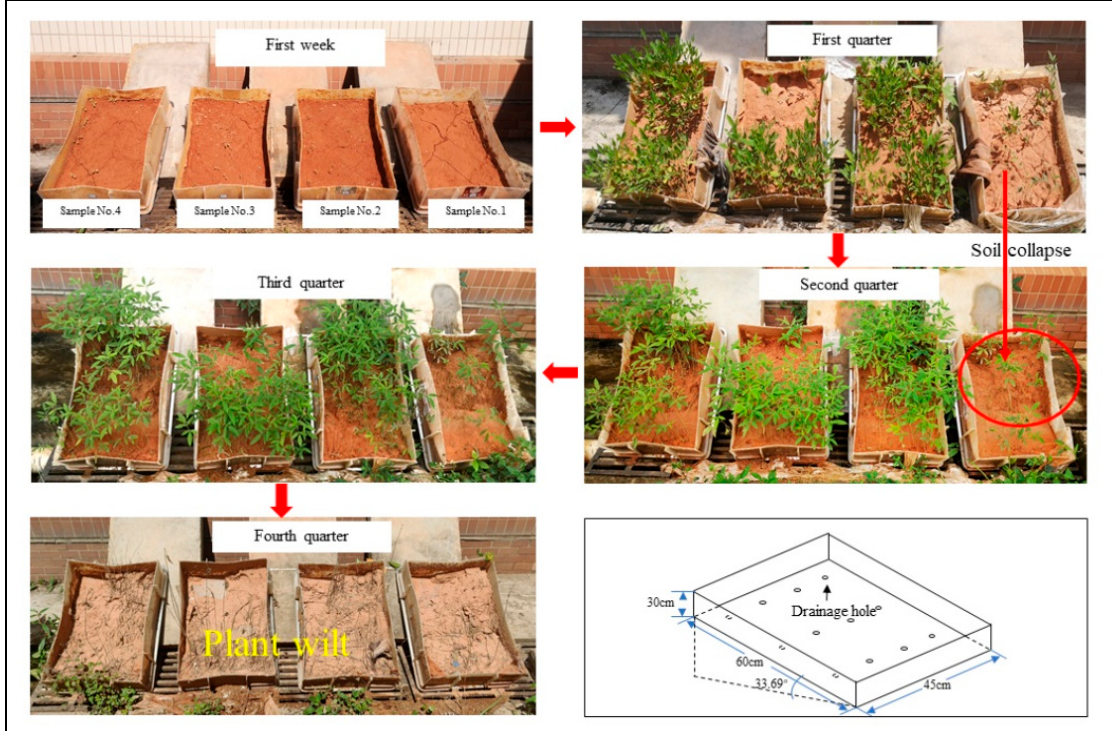
Figure 9. Plant growth effect.